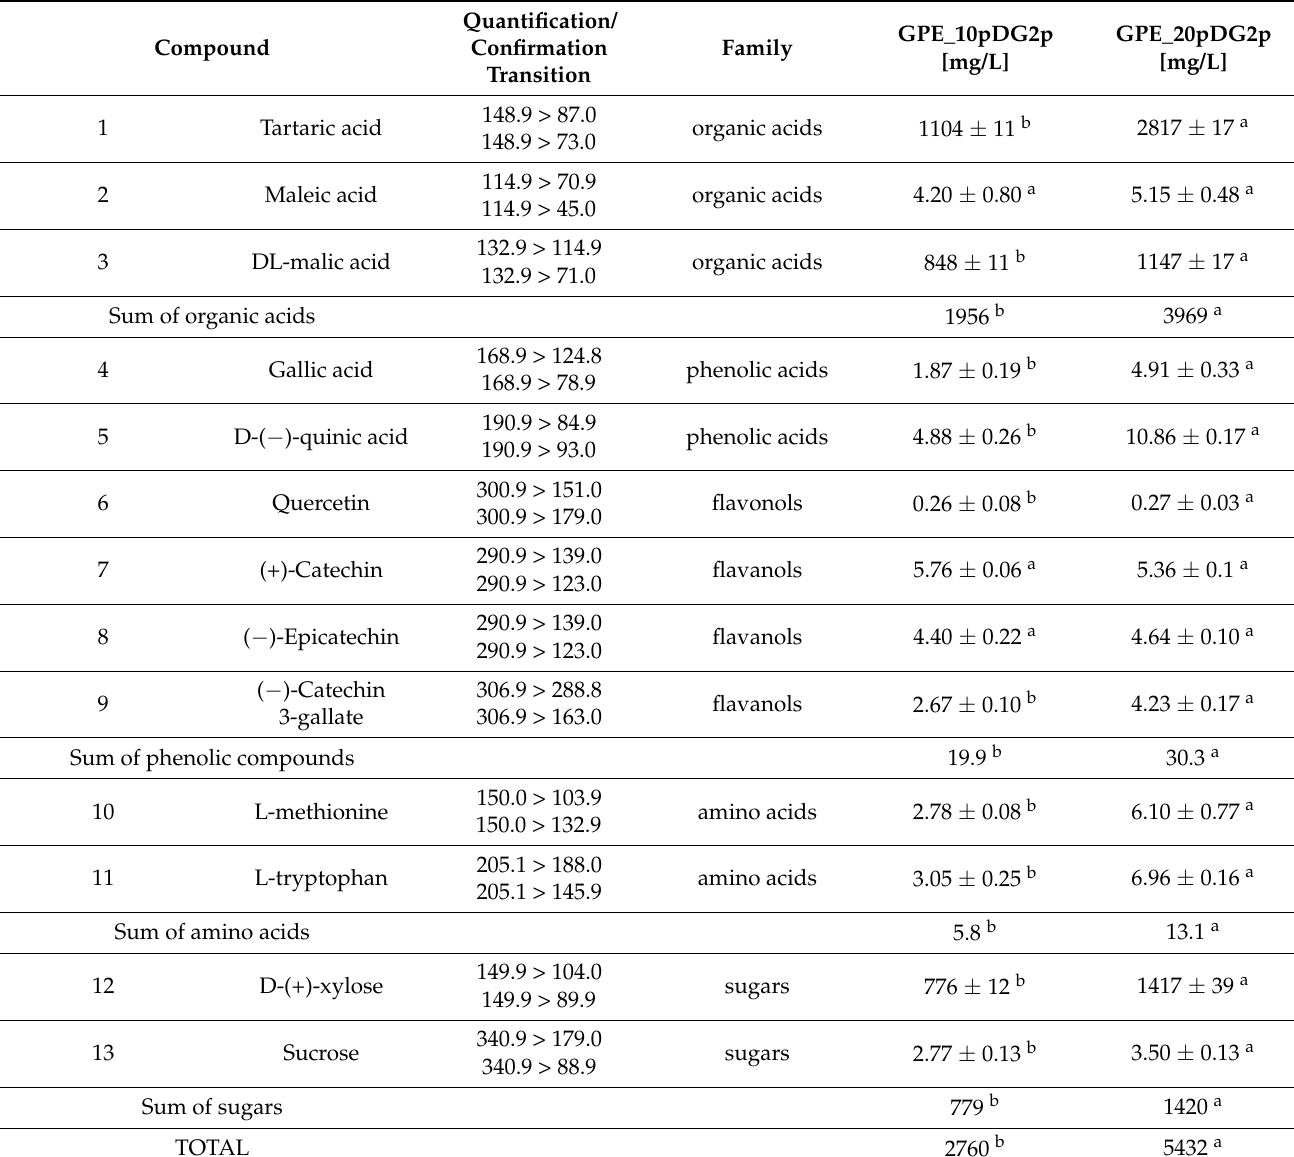
Table 1. UPLC-ESI-MS/MS quantification of the detected compounds in tested grape pomace extracts mean values ± standard deviation ( n =